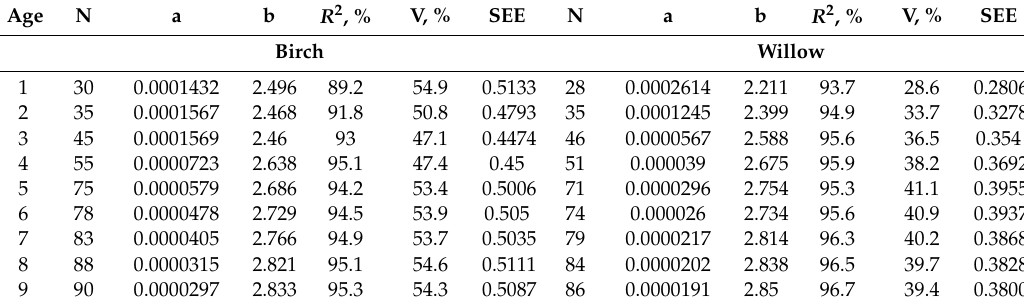
Table 2. Dry-mass equations for one- to nine-year-old birch and willow sprouts. Equations have the form Y = aX b , which after logarithmic transformation have been corrected with s 2 / s. Y = dry-mass (g), X = height of sprouts, a and b = constants, R 2 = degree of determination, V = coe ffi cient of variation, and N = number of sample sprouts, SEE = standard error of